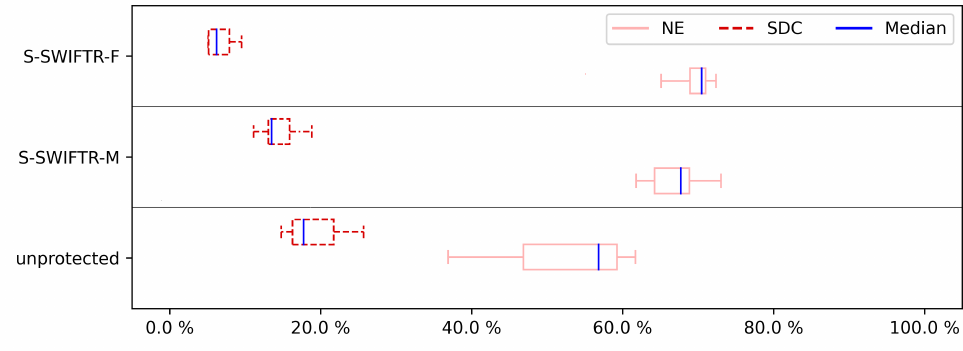
Figure 14. DFE small scale factory fault injection results for 1 register.